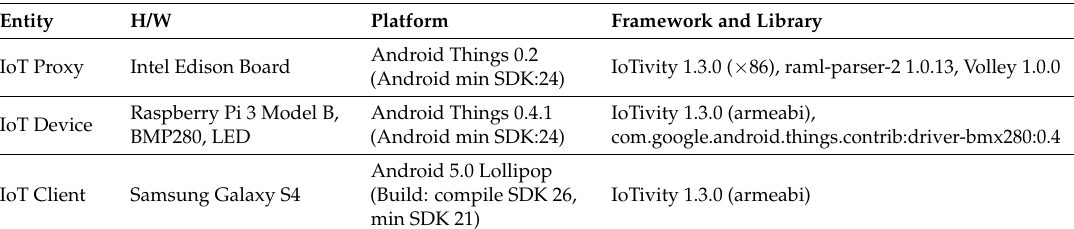
Table 1. Implementation environment